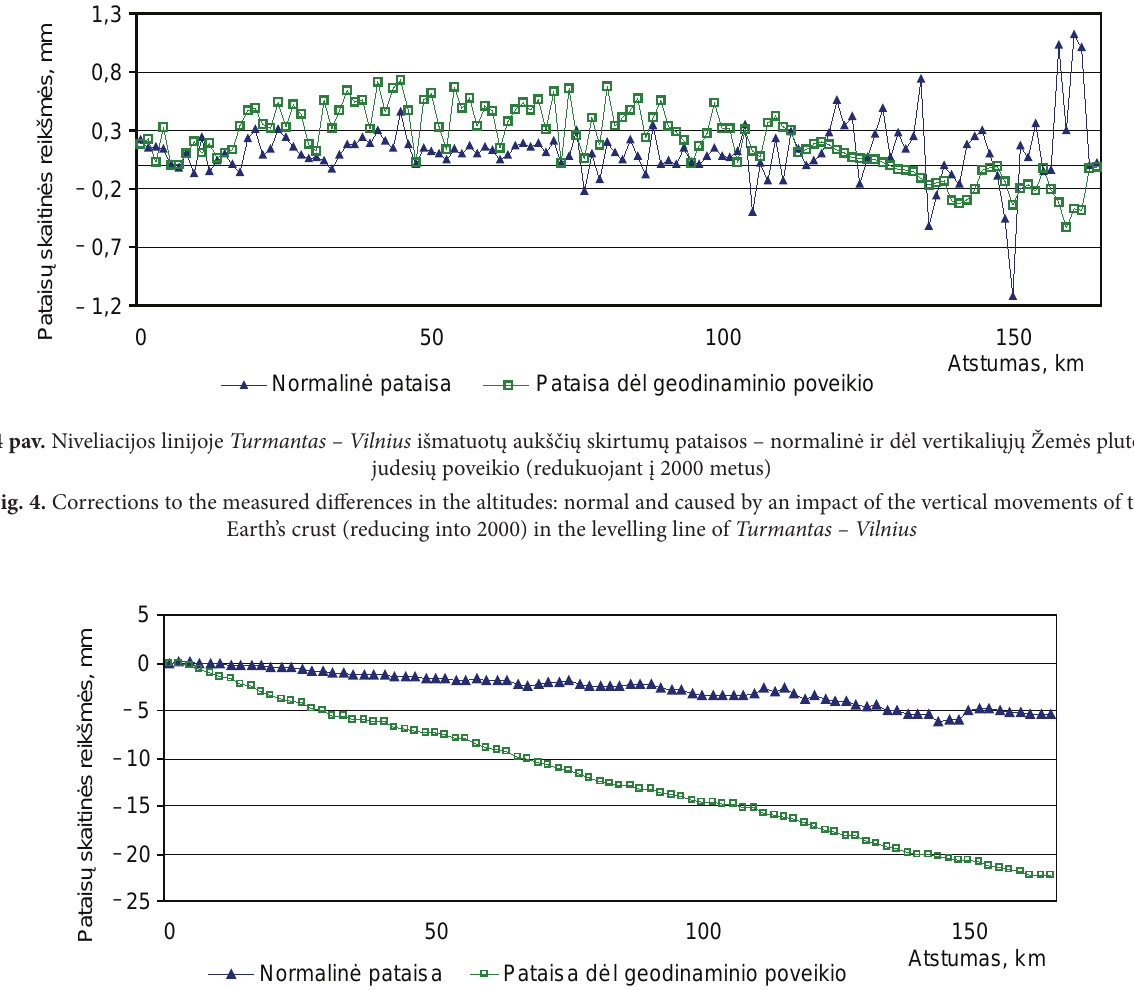
Fig. 5. Collections of normal corrections and corrections caused by an impact of the vertical movements of the Earth’s crust (reducing into 2000) in the levelling line of Jonava – Zarasai –